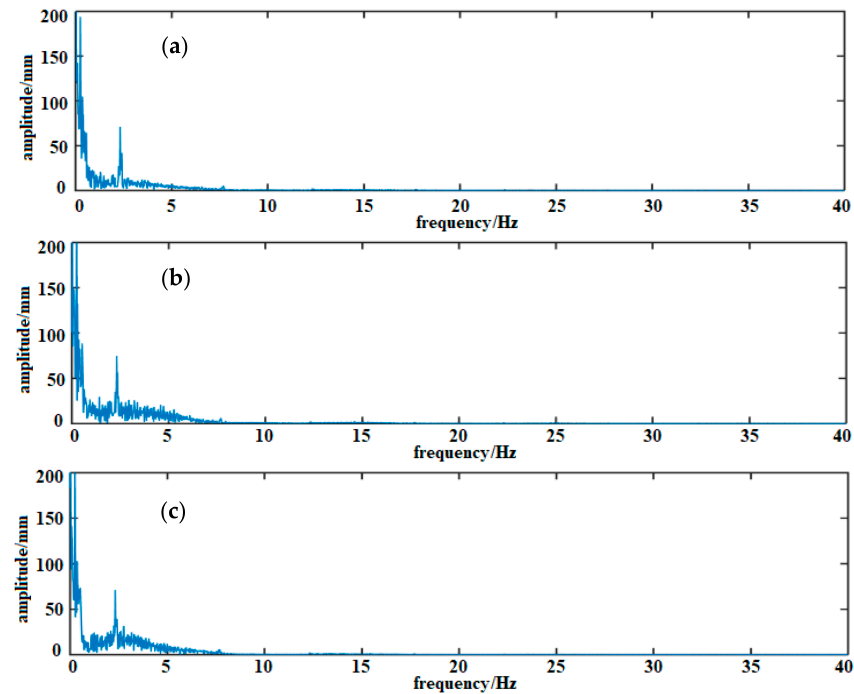
Figure 8. Three separated signal components found using the improved SOBI method. ( a ) Separated signal S1, ( b ) separated signal S2, and ( c ) separated signal S3.